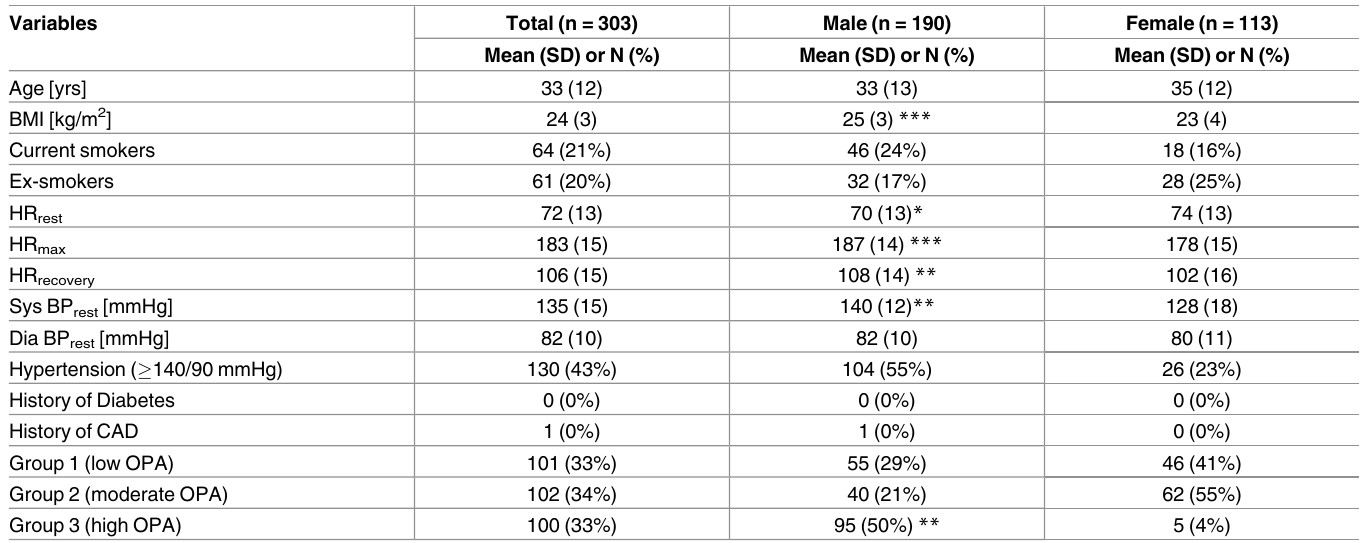
Table 2. Characteristics of study